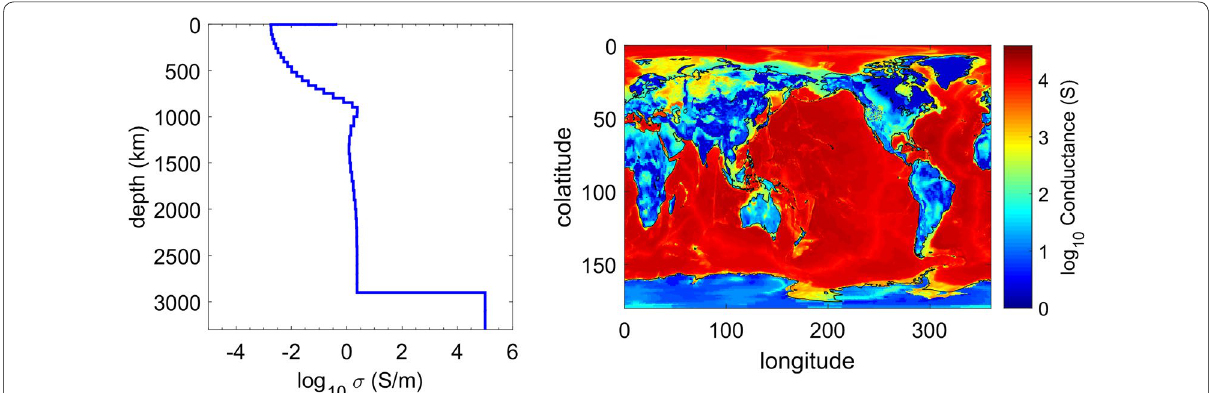
Fig. 1 Conductivity model used for modeling Sq and tidal EM fields. Left: 1-D conductivity model obtained from inversion of satellite and observa- tory data (Püthe et al. 2015). Right: 2-D conductance map (first 10 km). Sediment conductance values were taken from (Alekseev et al. 2015), and seawater conductivity came from (Grayver et al.